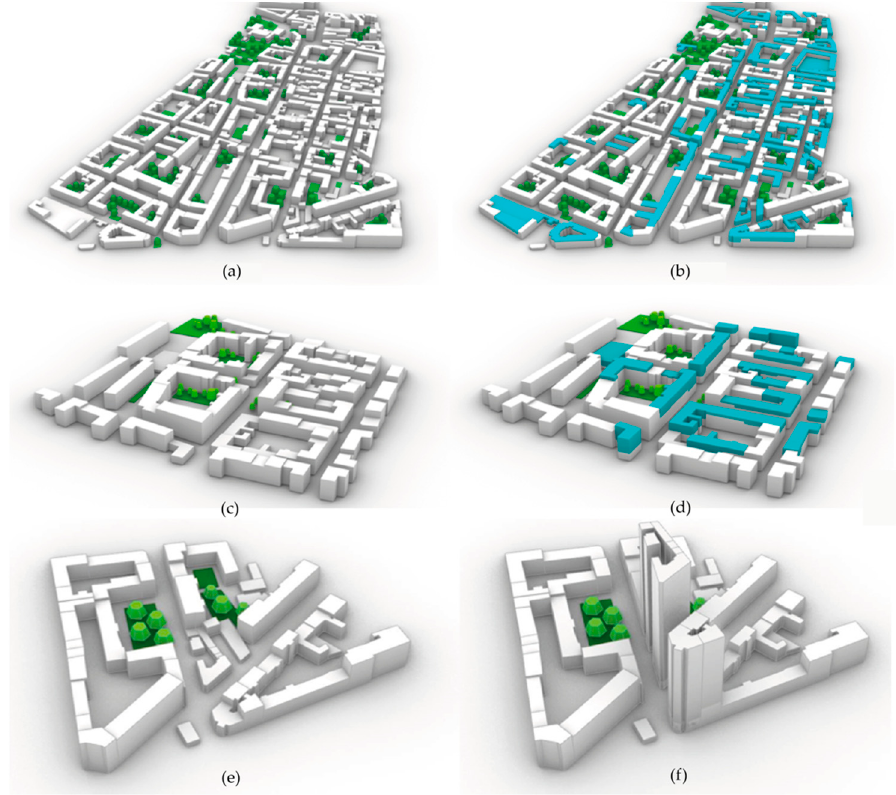
Figure 3. 3D model for the microclimate simulations for three subsets of the study area: Large domain for simulating large-scale general densification impacts for base case ( a ) and densification scenarios ( b ); sub-domain for simulating impacts of adaptation measures for base case ( c ) and densification scenarios ( d ); location for the simulation of the impact of a high-rise cluster for the base case ( e ) and densification scenarios ( f ).